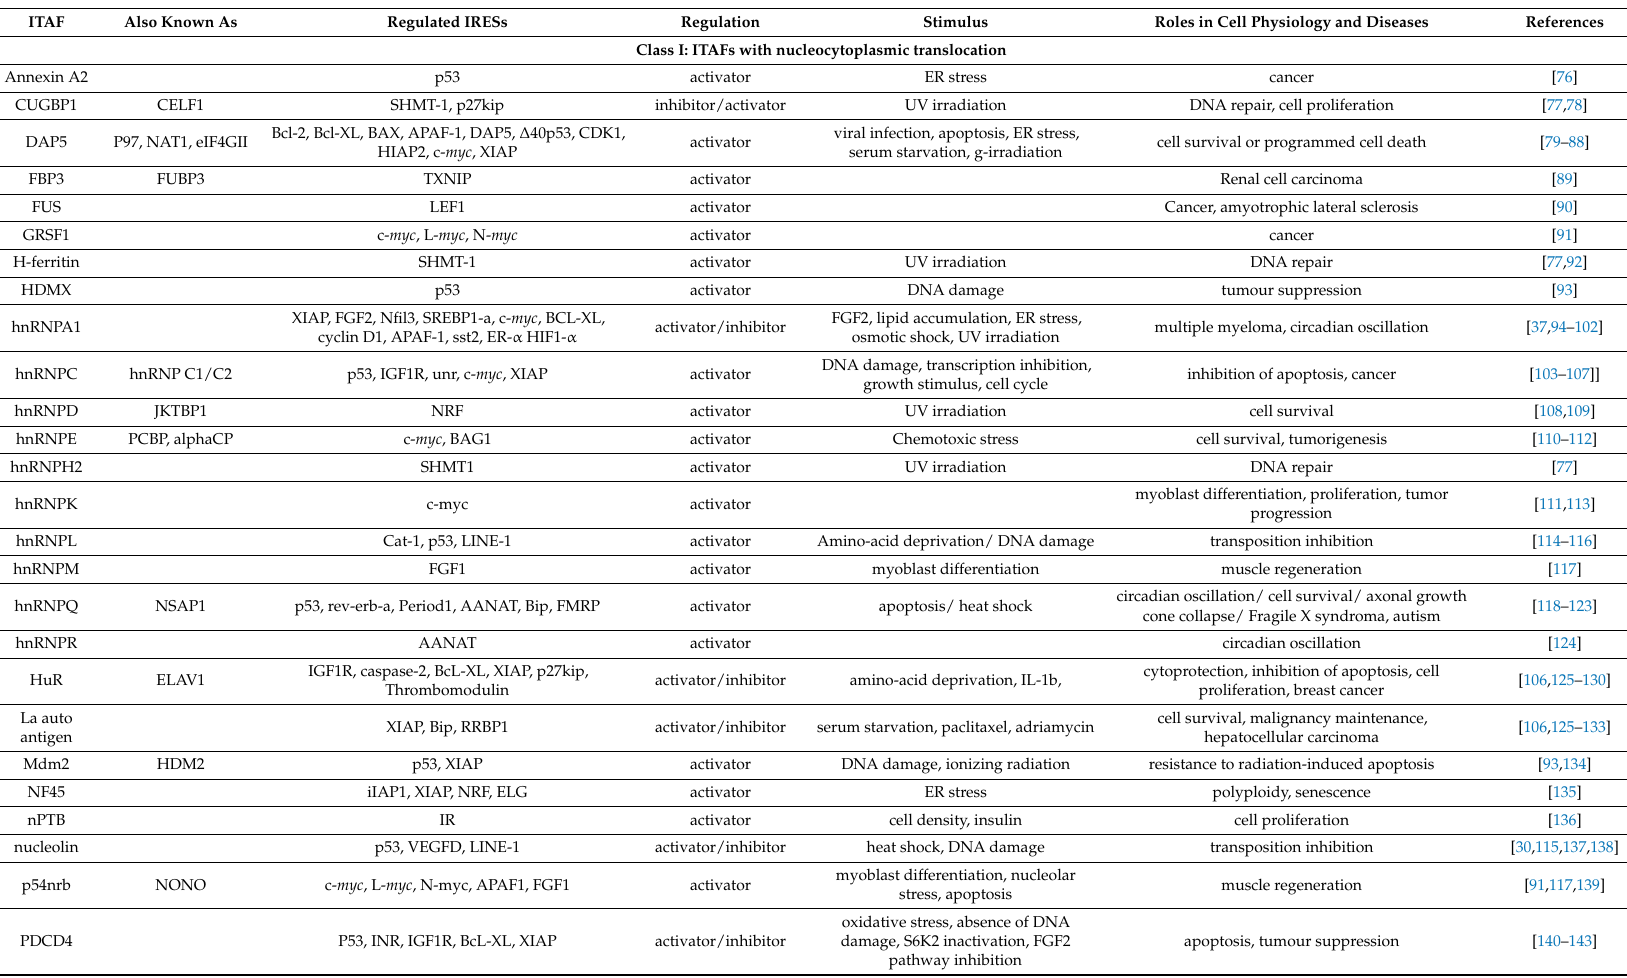
Table 1. An update of the reported IRES trans-acting factors (ITAFs) that regulate cellular IRESs. The different reported ITAFs regulating cellular IRESs are indicated. They are dispatched into three classes (see text). For each ITAF, the regulated IRESs, the type of regulation (activator or inhibitor), the described stimuli able to trigger their activity, the roles in cell physiology and diseases as well as the corresponding references are